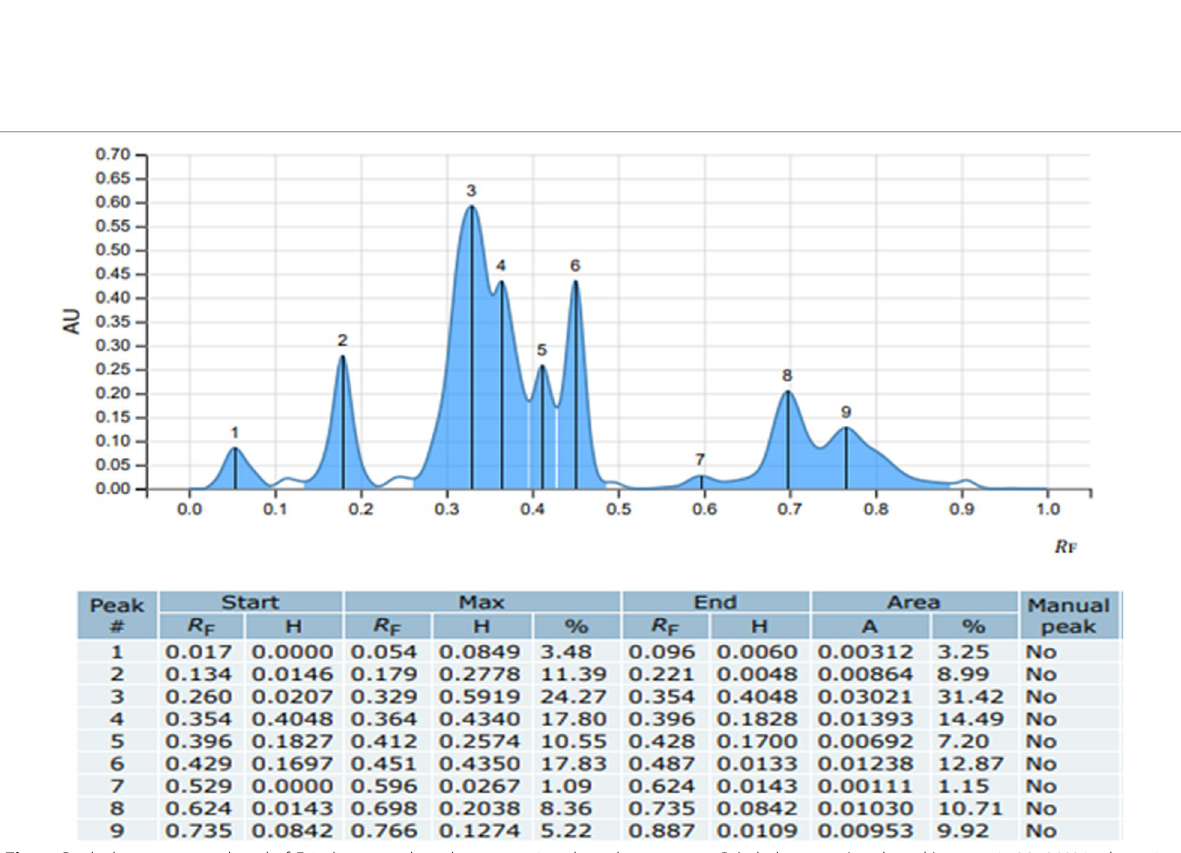
Fig. 7 Peak chromatogram band of E. indicum methanol extract using the solvent system B (ethyl acetate/methanol/ammonia 28–30% in the ratio of